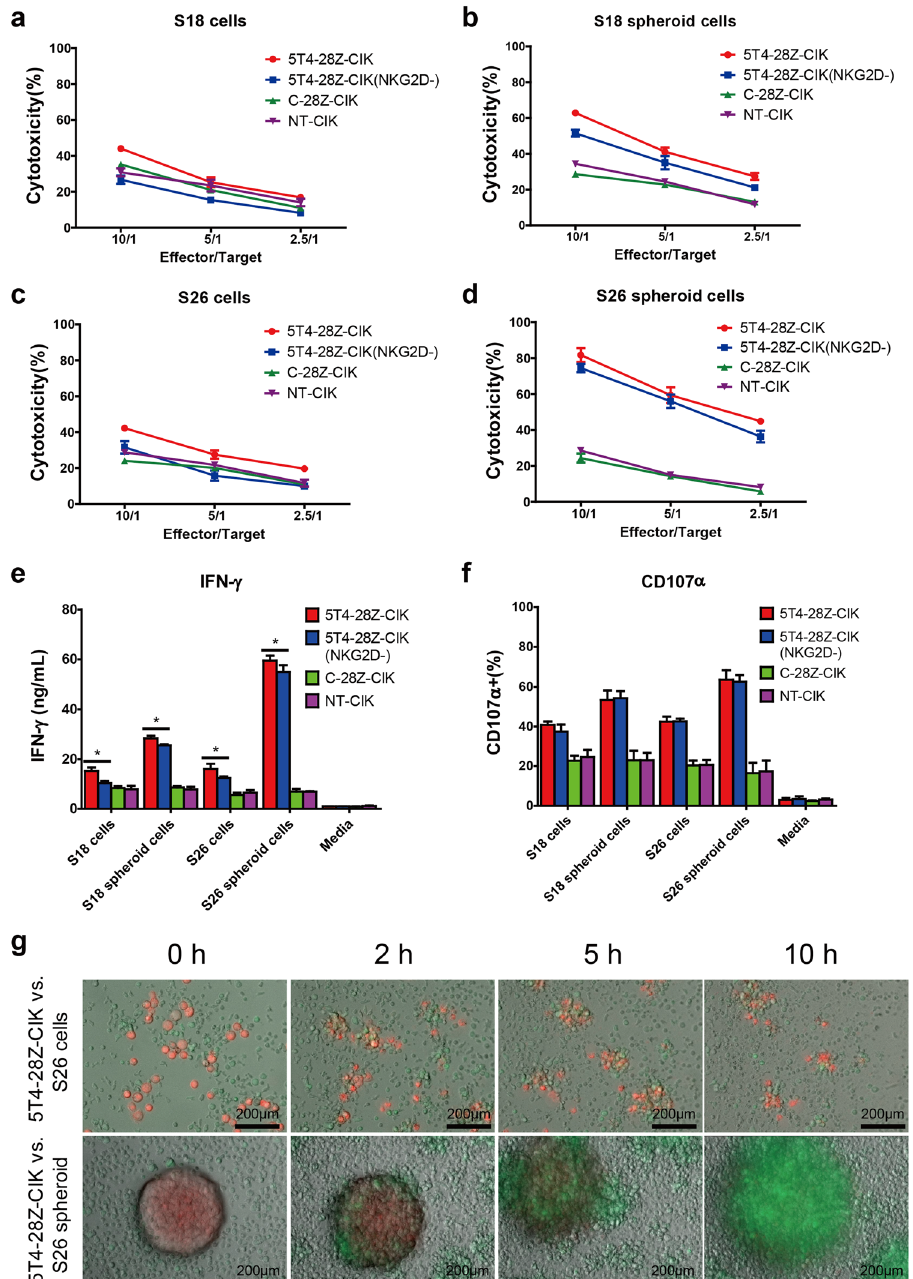
Figure 6. 5T4-28Z CAR gene modification promotes the anti-NPC activity of CIK cells in a 5T4-dependent manner. Target cells consisted of 5T4 low-expressing S18 and S26 cells and their spheroid cells with an intermediate or high level of 5T4 expression. Effector cells included 5T4-28Z-CIK, 5T4-28Z-CIK (NKG2D-), C-28Z-CIK and NT-CIK cells. ( a–d ) Briefly, 1 × 10 4 target cells per well were co-cultured with different effector cells at E/T ratios of 10/1, 5/1 and 2.5/1 for 4 h. The cytotoxicity of effector cells was examined with LDH release assays. Values in the line graphs represent the mean ± SD of three parallel wells. ( e ) Then, 2 × 10 4 target cells per well were co-incubated with 1 × 10 5 effector cells per well for 24 h. Effector cells cultured alone in medium served as the negative control. IFN- γ production of the effector cells was assessed using ELISAs. Values in the histogram represent the mean ± SD of three parallel wells. ( f ) In addition, 2 × 10 5 target cells per well were co- cultured with 1 × 10 6 effector cells per well for 5 h in the presence of 1 × Protein Transport Inhibitor Cocktail and anti-human CD107 α -APC antibody or IgG isotype control. Effector cells cultured alone served as the negative control. Degranulation of effector cells was evaluated using FACS. Values presented in the histogram represent the mean ± SD of triplicate samples. ( g ) S26 cells or S26 spheroids labelled with CM-Dil were co- cultured with 5T4-28Z-CIK cells and monitored using an inverted fluorescence microscope with climate control. Images captured intermittently are displayed. The results are representative of at least three independent experiments. * indicates p < 0.05 (one-way